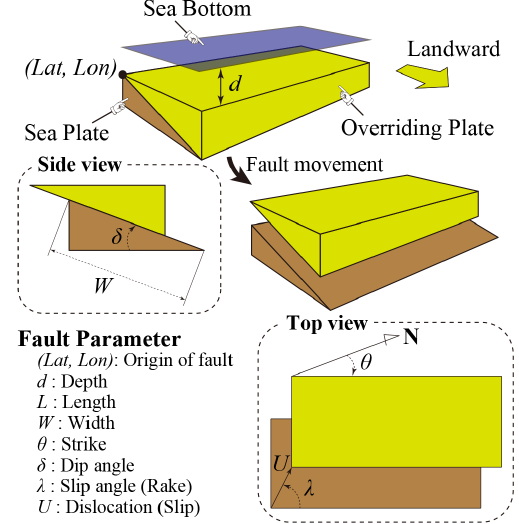
Figure 3. Illustration of the fault parameters (adapted from Kotani et al.,